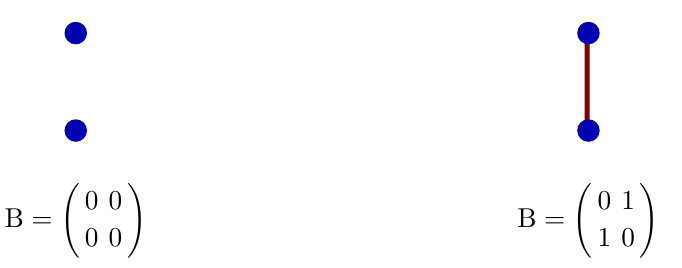
Figure 3 . Graphs and their adjacency matrix associated with the first code in (6.7) (left) and the first code in (6.8)